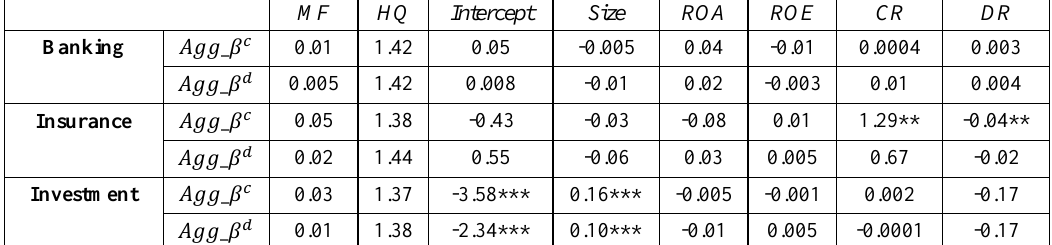
Table 7: Effect of firm characteristics on stock aggressiveness